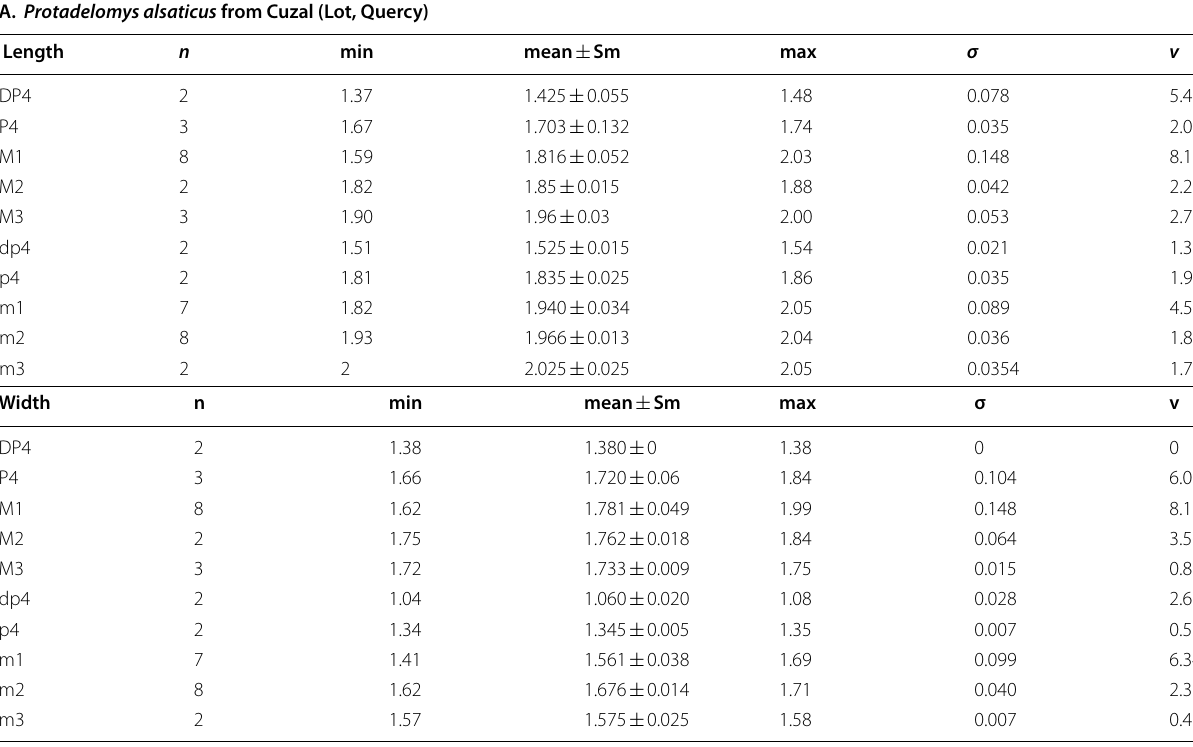
Sm σ/ √ n ; v 100 σ/average L or W). of the different ± = =